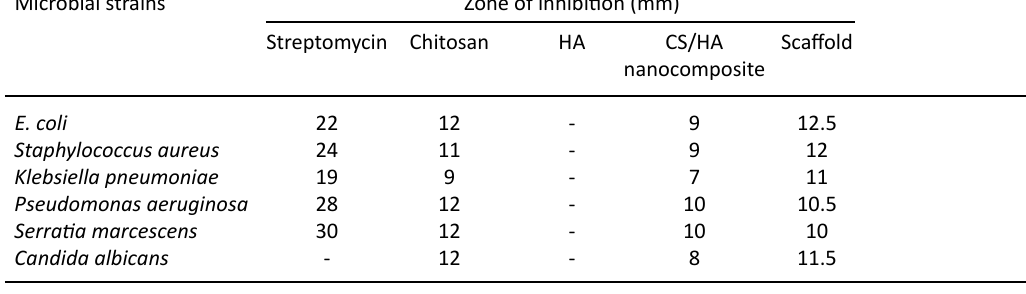
Table 3. Zone of inhibition of nanocomposite against different pathogen Microbial strains Zone of inhibition